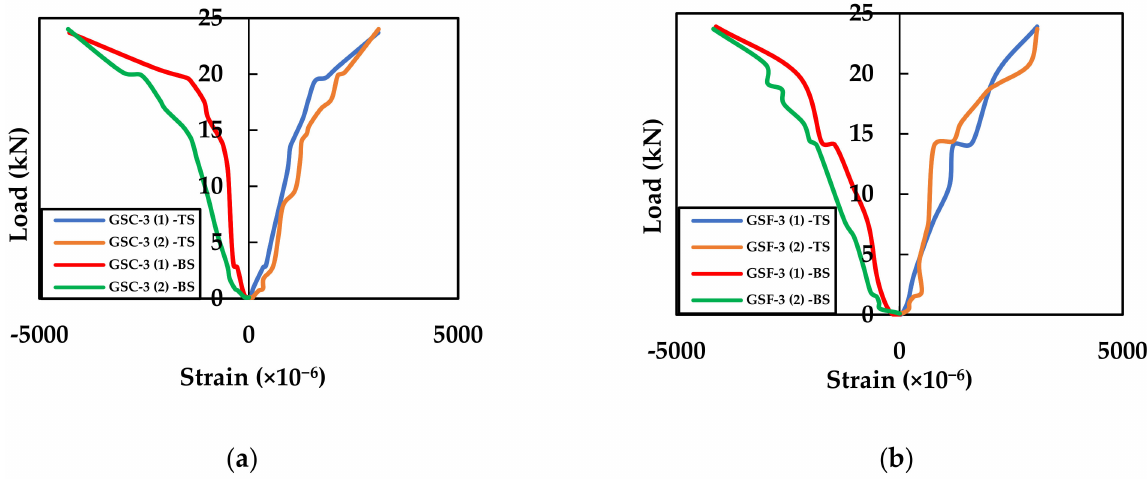
Figure 13. Load–strain behaviour of ( a ) GSC-3 and ( b ) GSF-3. TS—top strain, BS—bottom strain.